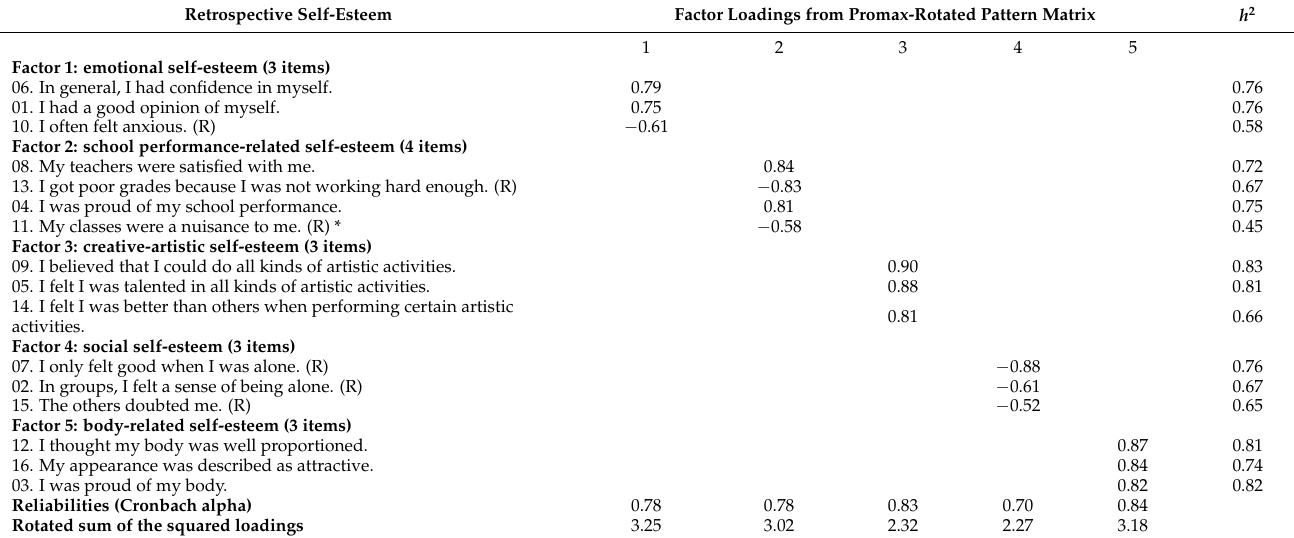
Table 2. Results From a Factor Analysis of the Retrospective Domain-Specific Self-Esteem